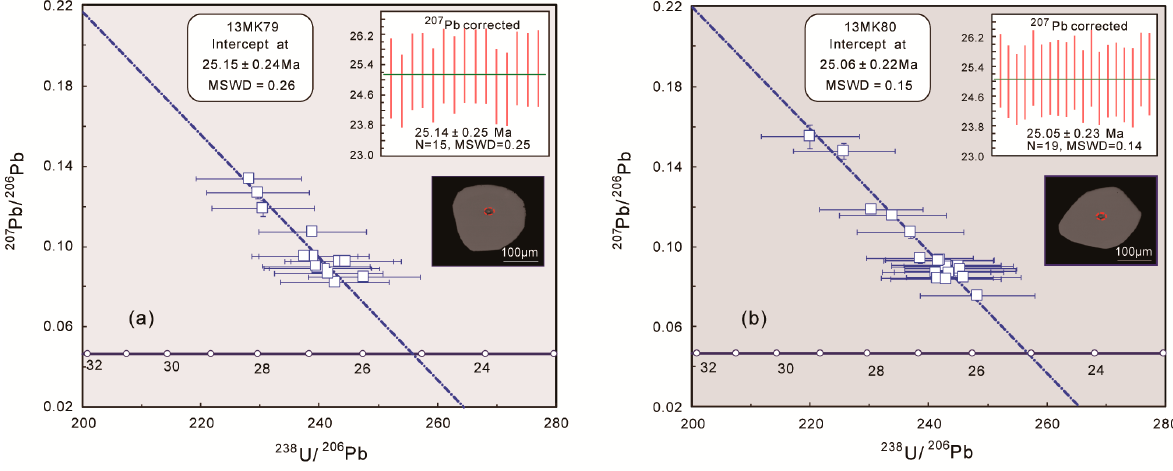
Figure 3. Tera–Wasserburg inverse U–Pb concordia diagrams for titanite from two ruby-bearing marbles from the Mogok Stone Tract. Data point error bars are at the 2 σ level. ( a ) Tera–Wasserburg inverse U–Pb concordia diagram for titanite from ruby-bearing marble (13MK79). ( b ) Tera–Wasserburg inverse U–Pb concordia diagram for titanite from ruby-bearing marble (13MK80). Table 1. U–Th–Pb analytical results of titanite in ruby ‐ bearing marbles from the Mogok Stone Tract.